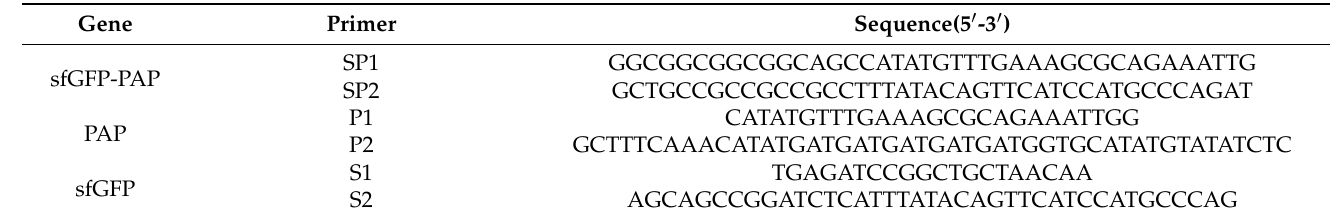
Table 1. Primers used in this